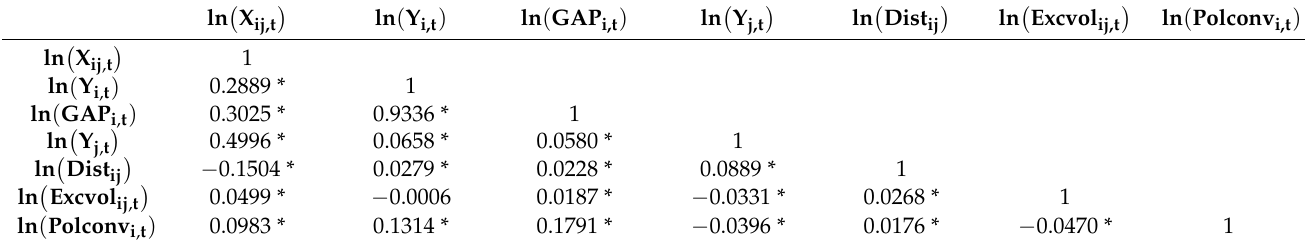
Table 2. Correlation Coefficients of the